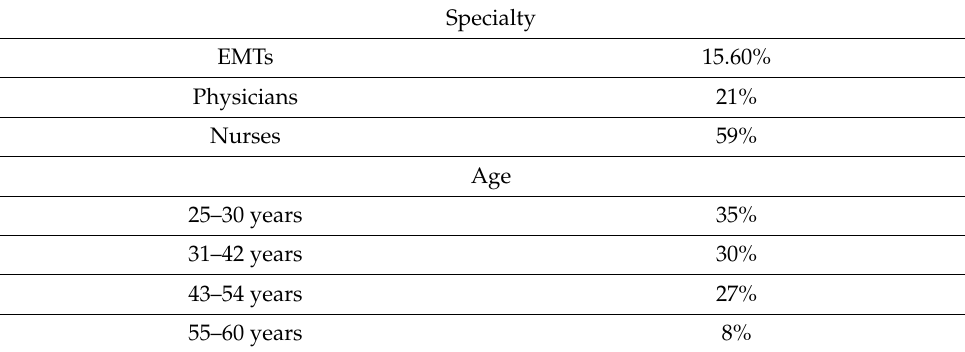
Table 1. Participant age groups and specialties.